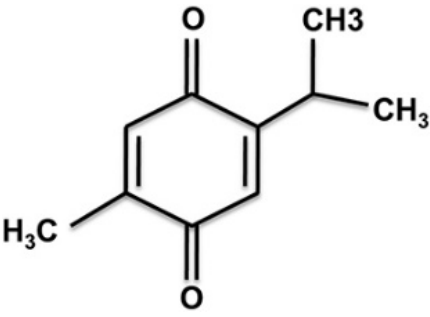
Figure 1. Thymoquinone’s chemical structure. Thymoquinone (2-isopropyl-5-methylbenzo-1, 4-quinone) is the main active ingredient in black seed volatile oil ( Nigella sativa L.).